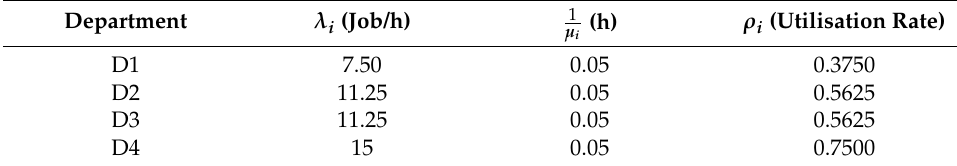
Table 1. Arrival rate, service rate and utilisation rate of the departments.